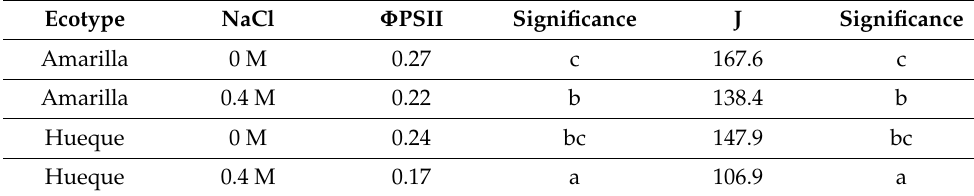
Table 3. Harvested energy efficiency ( Φ PSII) and rate of linear electron transport (J).